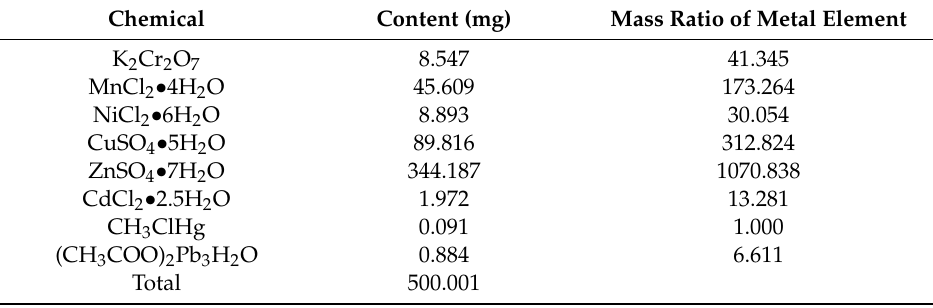
Table 1. The contents and proportions of di ff erent heavy metals composed in the